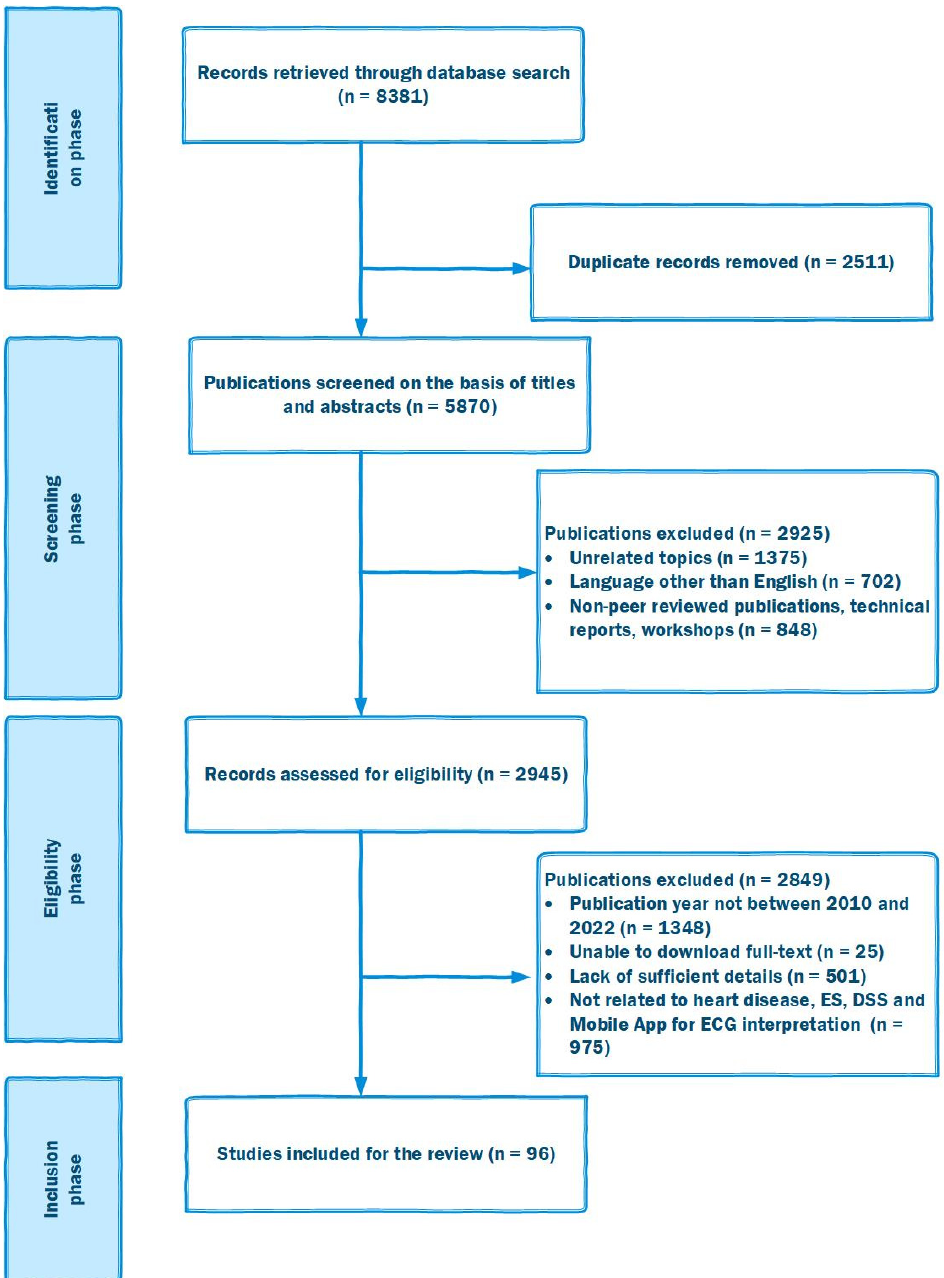
Figure 1. Study selection flow chart based on the PRISMA model. Table 1. Summary of the studies on ES and DSS for electrocardiogram interpretation and diagnosis.